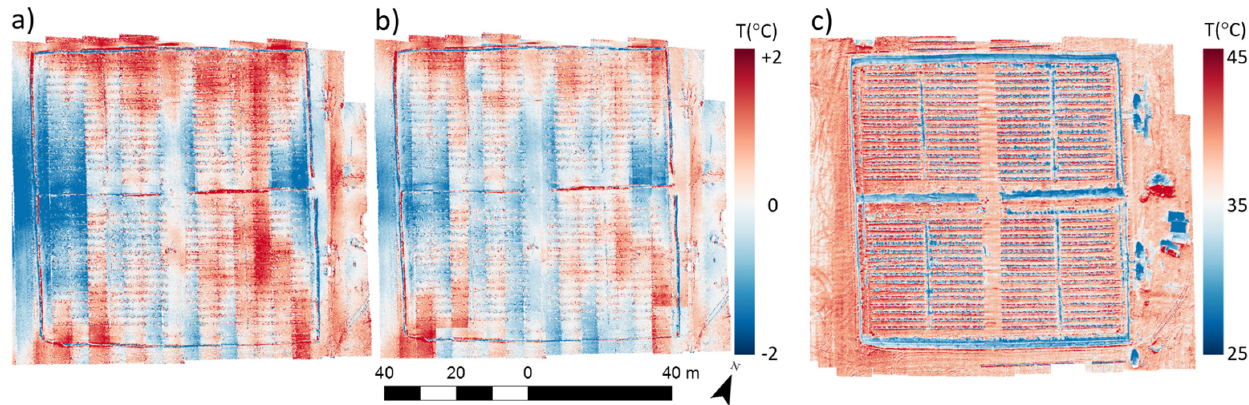
Figure 9. Difference in temperature between inbound and outbound orthophotos ( a ) before and ( b ) after the flight direction normalization and ( c ) the final temperature orthomosaic using the swath-based correction method. The presented example represents the thermal UAV data collected on 20 December 2017 at 10:19–10:35.